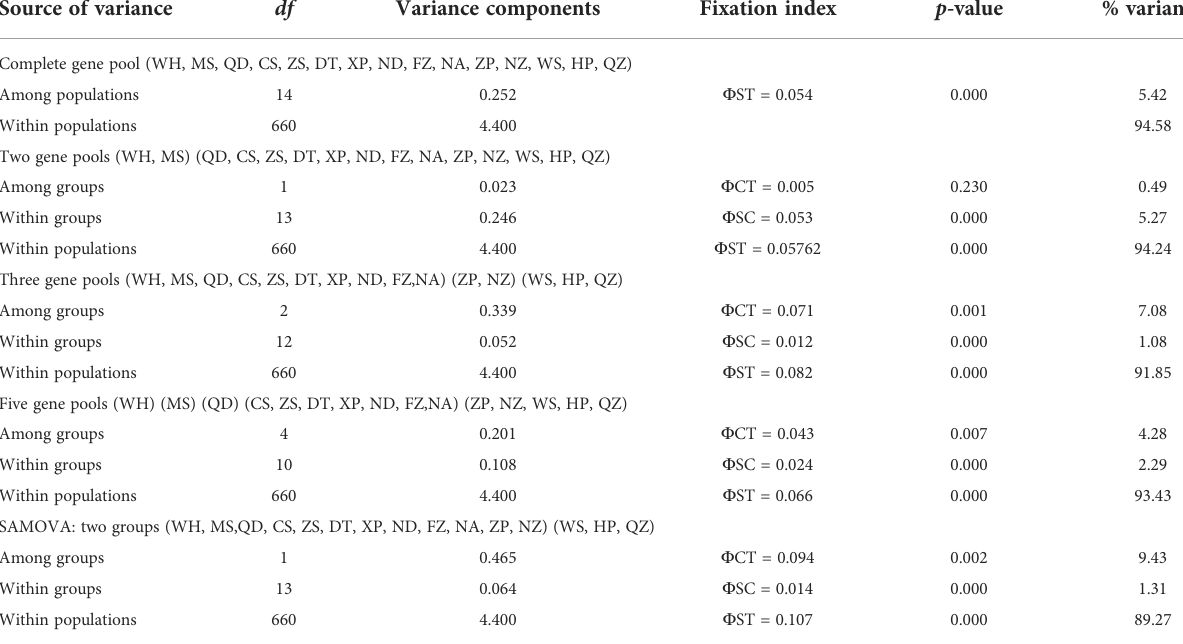
TABLE 2 Analysis of molecular variance (AMOVA) and spatial analysis of molecular variation (SAMOVA). Source of variance df Variance components Fixation index p -value %